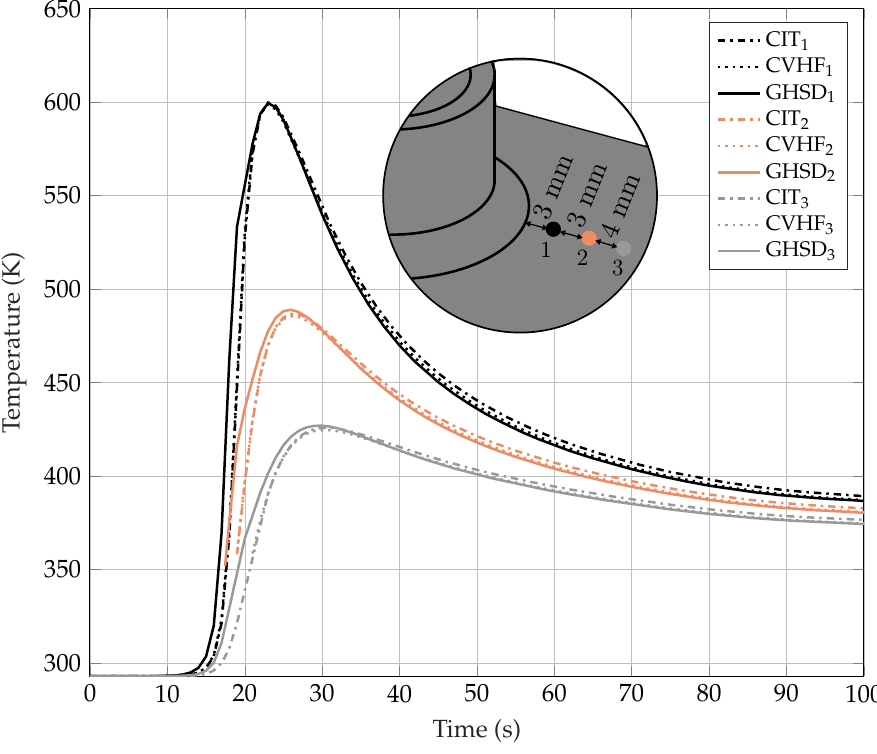
Figure 14. Temperature vs. Time curve of the thermal models employed, specifically for three points on the surface of the plate.